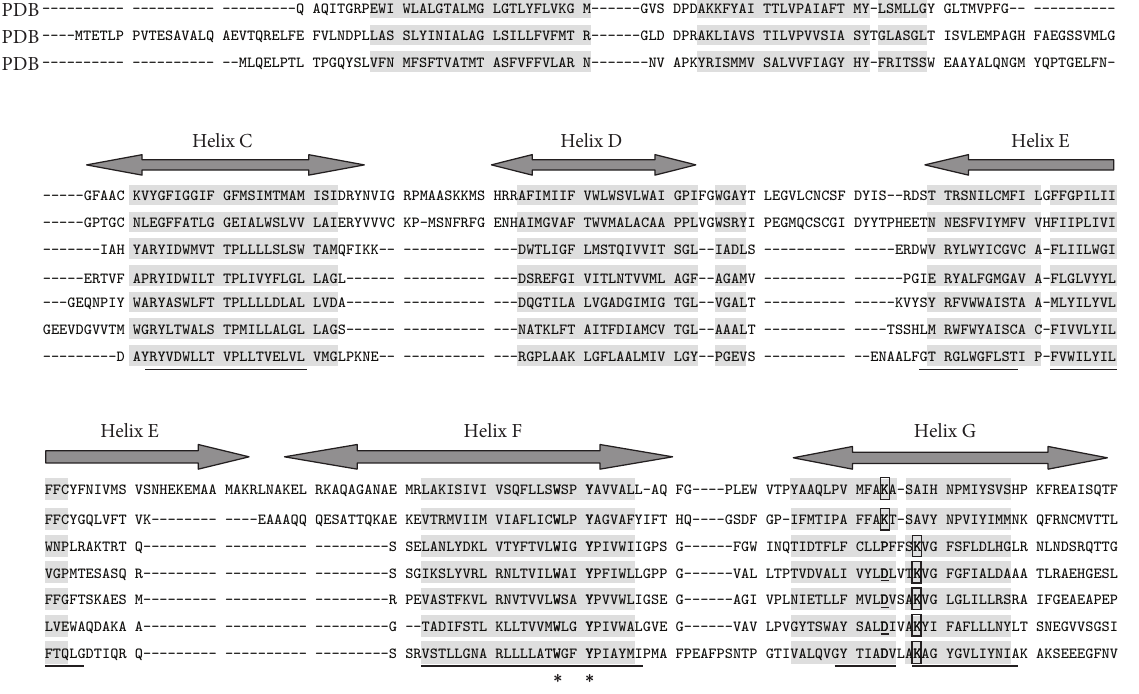
Figure 1: Structure alignment of squid rhodopsin (2Z73:A | PDB, metazoan rhodopsin), bovine rhodopsin (1U19:A | PDB, metazoan rhodopsin), Anabaena sensoryrhodopsin(1XIO:A | PDB,microbialrhodopsin), Natronomonas sensoryrhodopsinII(1GU8:A | PDB,microbial rhodopsin), Halobacterium salinarum bacteriorhodopsin (1JV6:A | PDB, microbial rhodopsin), Natronomonas halorhodopsin (3A7 K:A | PDB, microbial rhodopsin), and Salinibacter ruber xanthorhodopsin (3DDL:A | PDB, microbial rhodopsin). Squid rhodopsin is used as the template for delineating seven-transmembrane helices. Shaded residues are structural homologues. Conserved tryptophan and tyrosine in WXXY motif are marked with black asterisks. The retinal-binding lysine is in bold style and boxed. The aspartic acid in microbial rhodopsin corresponding to the retinal-binding lysine in metazoan rhodopsin is in bold style and underlined. The test region is marked with thin